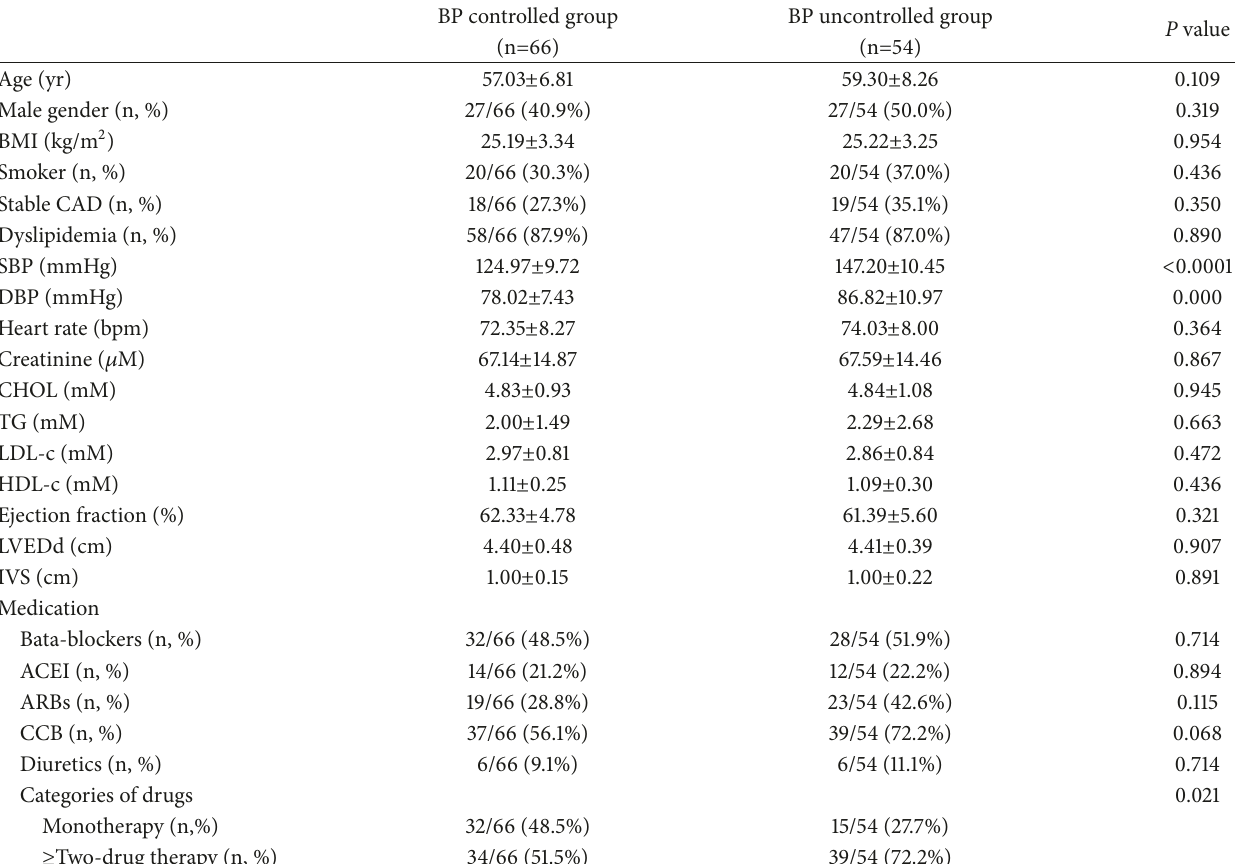
Table 3: Clinical characteristics of hypertensive patients with controlled blood pressure group and uncontrolled blood pressure group.